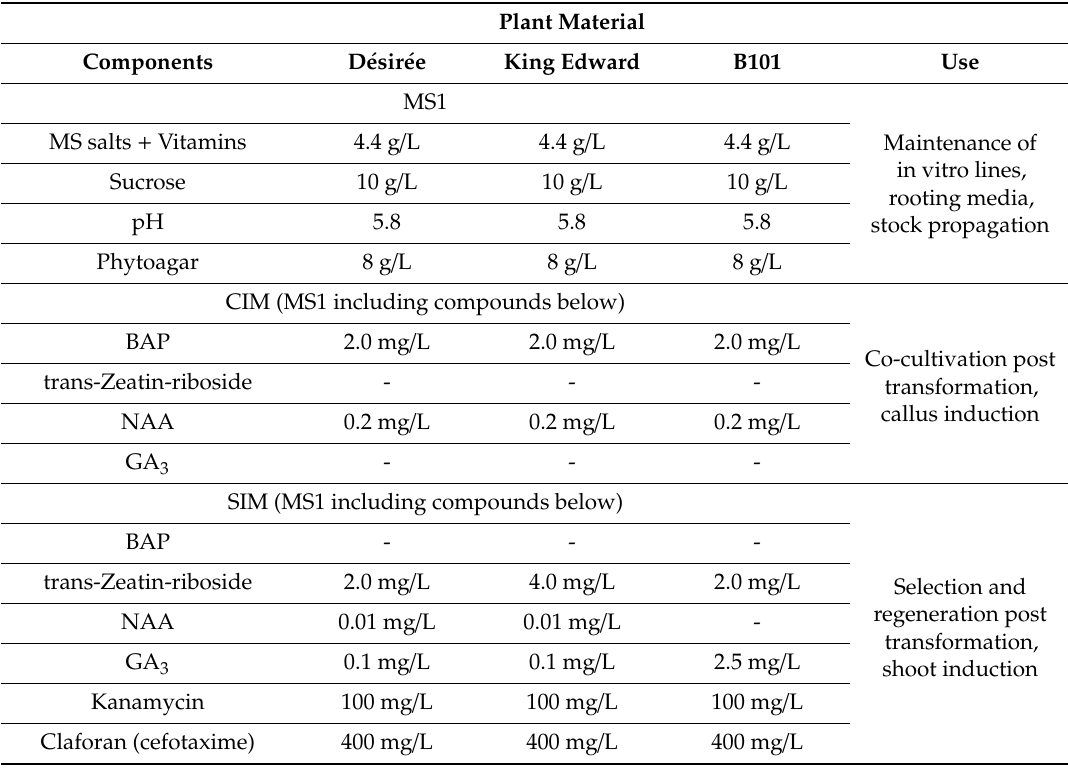
Table 1. Media Composition for the maintenance, transformation, selection, and regeneration of D é sir é e, King Edward, and the B101 plant material. CIM = Callus induction media; SIM = Shoot induction media. In bold are major optimizations suggested from this